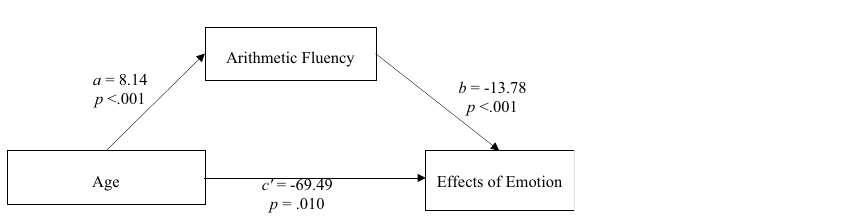
Figure 3. Simple mediation model for arithmetic